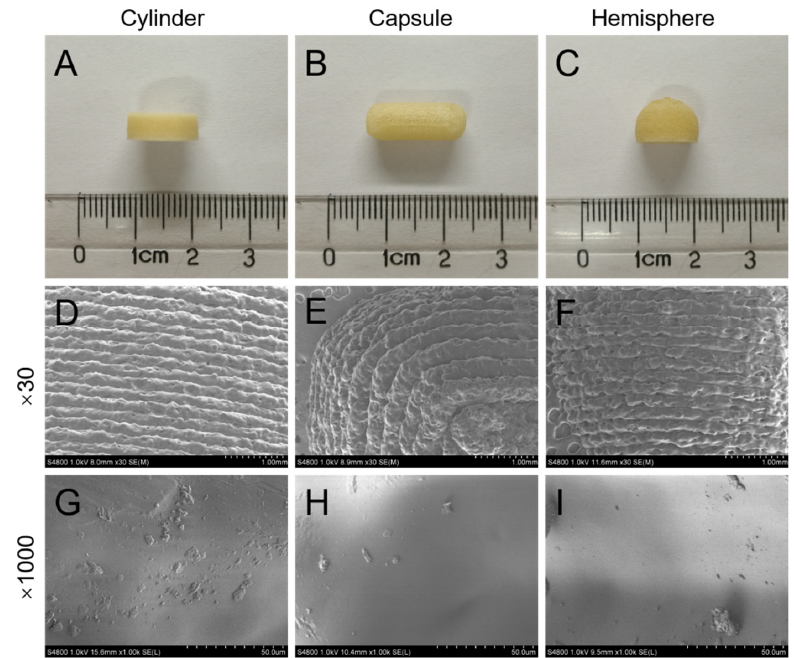
Figure 4. Photographs ( A – C ) and SEM ( D – I ) images of the cylinder, capsule and hemisphere formulations.